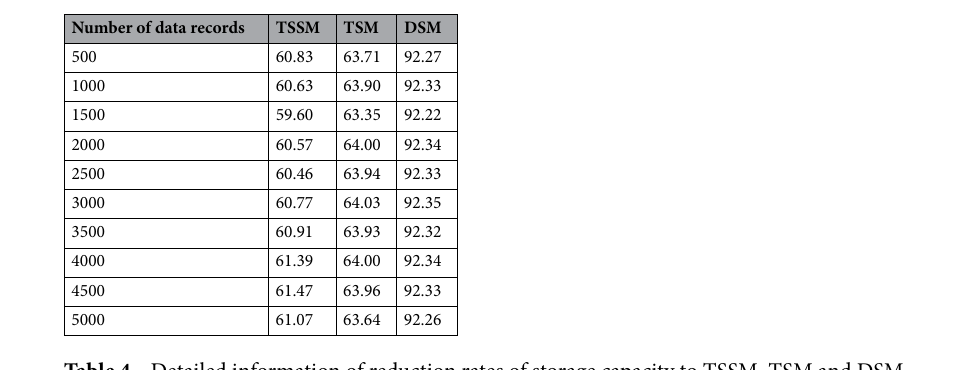
Table 4. Detailed information of reduction rates of storage capacity to TSSM, TSM and